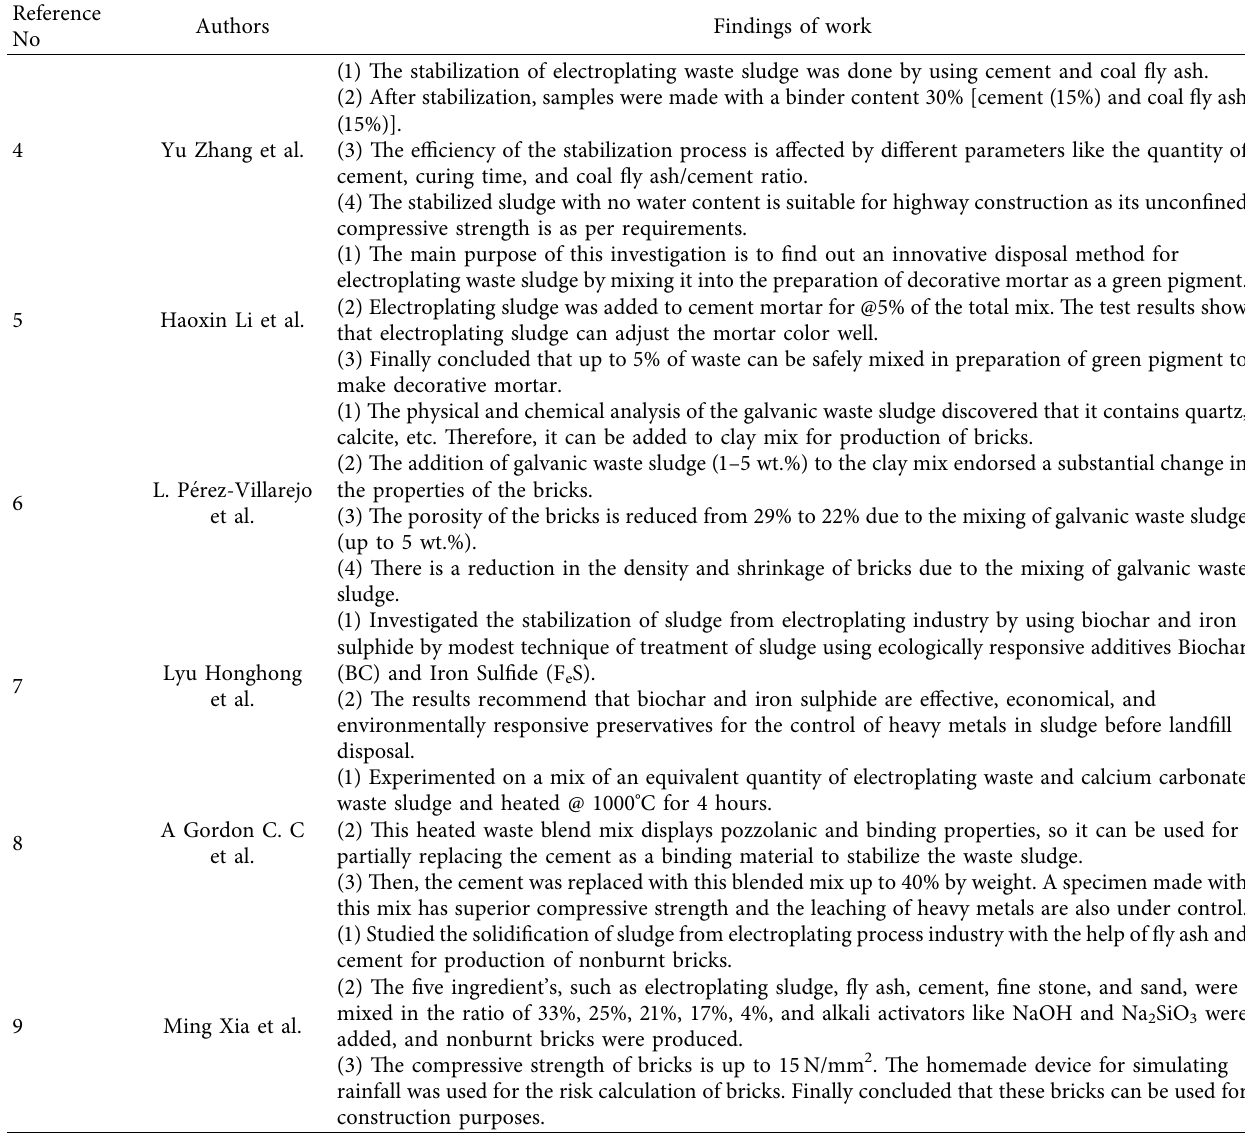
Table 1: Summary of previous work related to polymer-based bricks, paver blocks, and